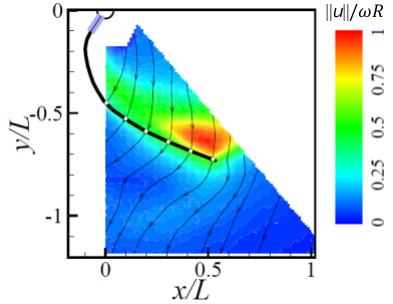
Figure 6. Phase-locked distribution of the velocity magnitude with superimposed streamlines in the vicinity of the medium plate at ω = 120 rpm.